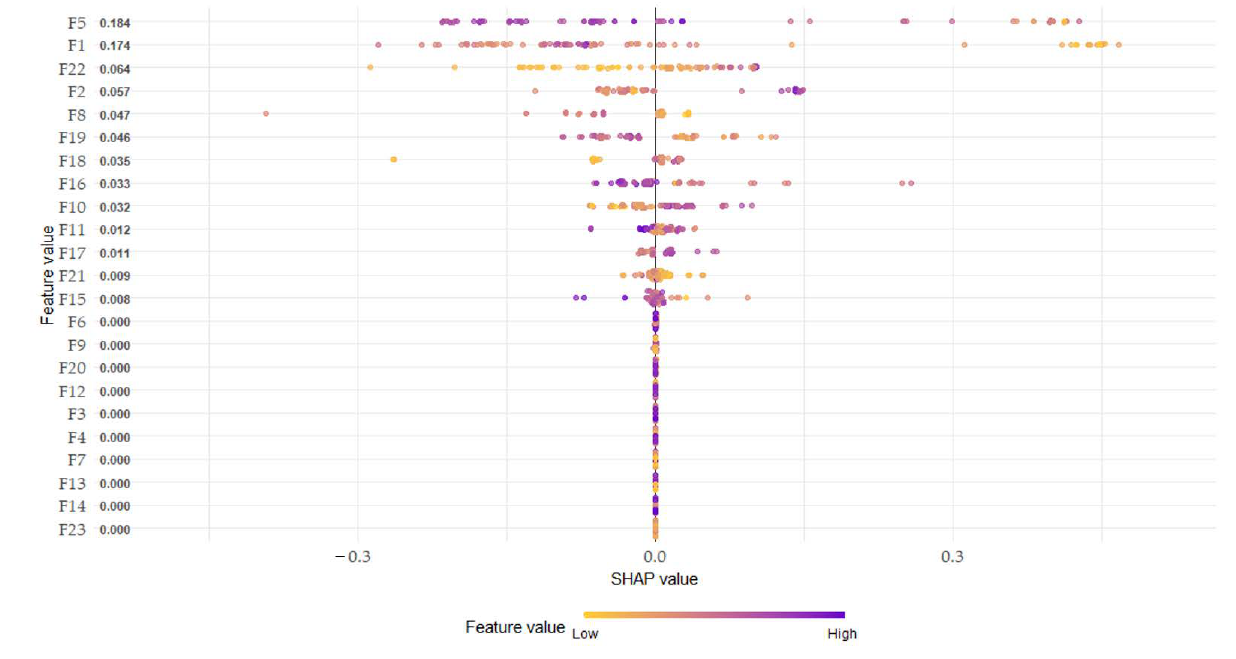
Figure 2. Summary plot of spatial-temporal